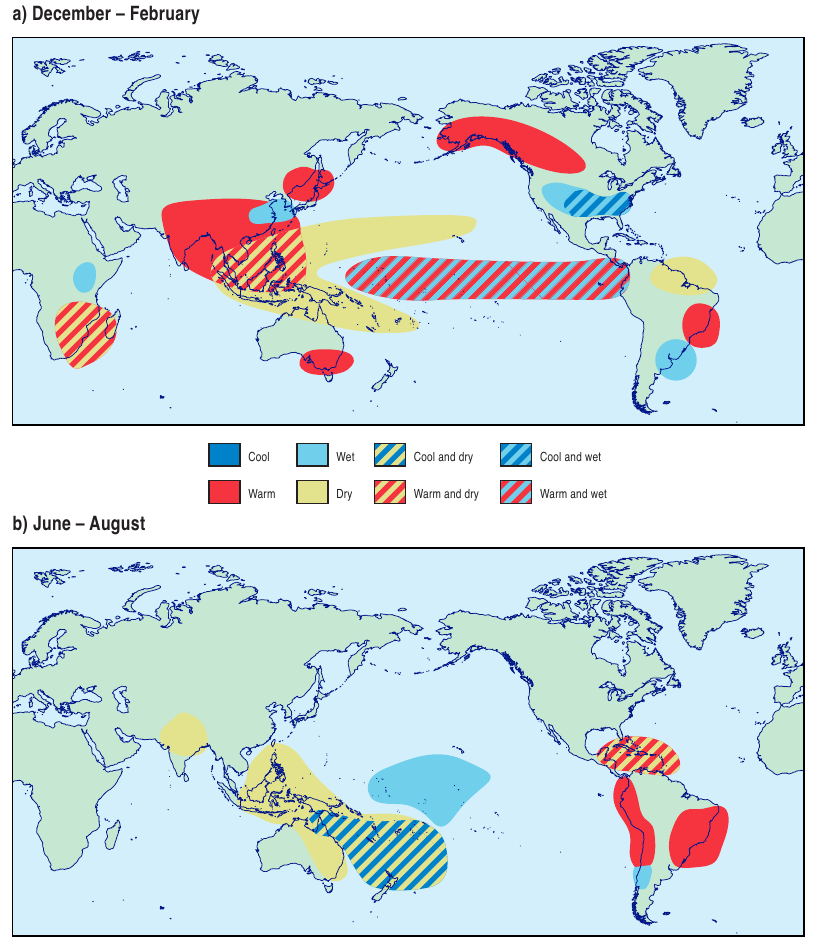
Figure 7. Canonical climate impact patterns of El Niño for ( a ) December–February and ( b ) June–August. Sourced and redrawn from the Climate Predicition Centre http://www.cpc.ncep.noaa.gov/products/